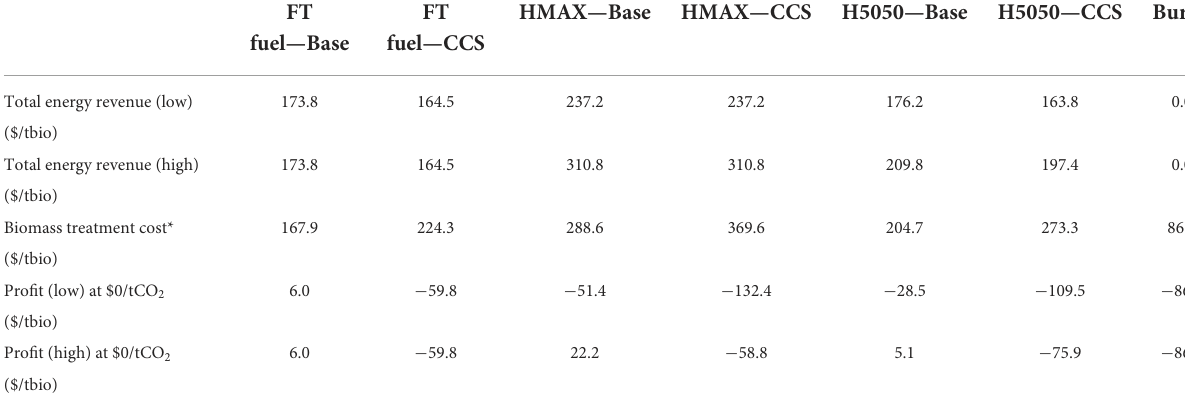
TABLE 6 Data used to generate plots for Case 2, based on data from Larson et al. (2009) and equations from Baker et al. (2020).